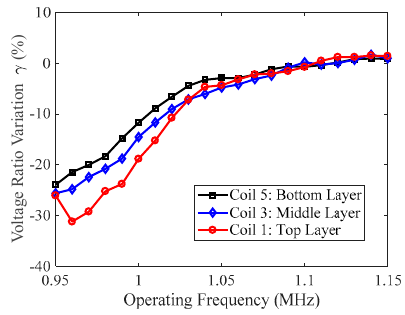
Figure 16. Measurements of γ varying with f for Coils 1, 3, and 5.